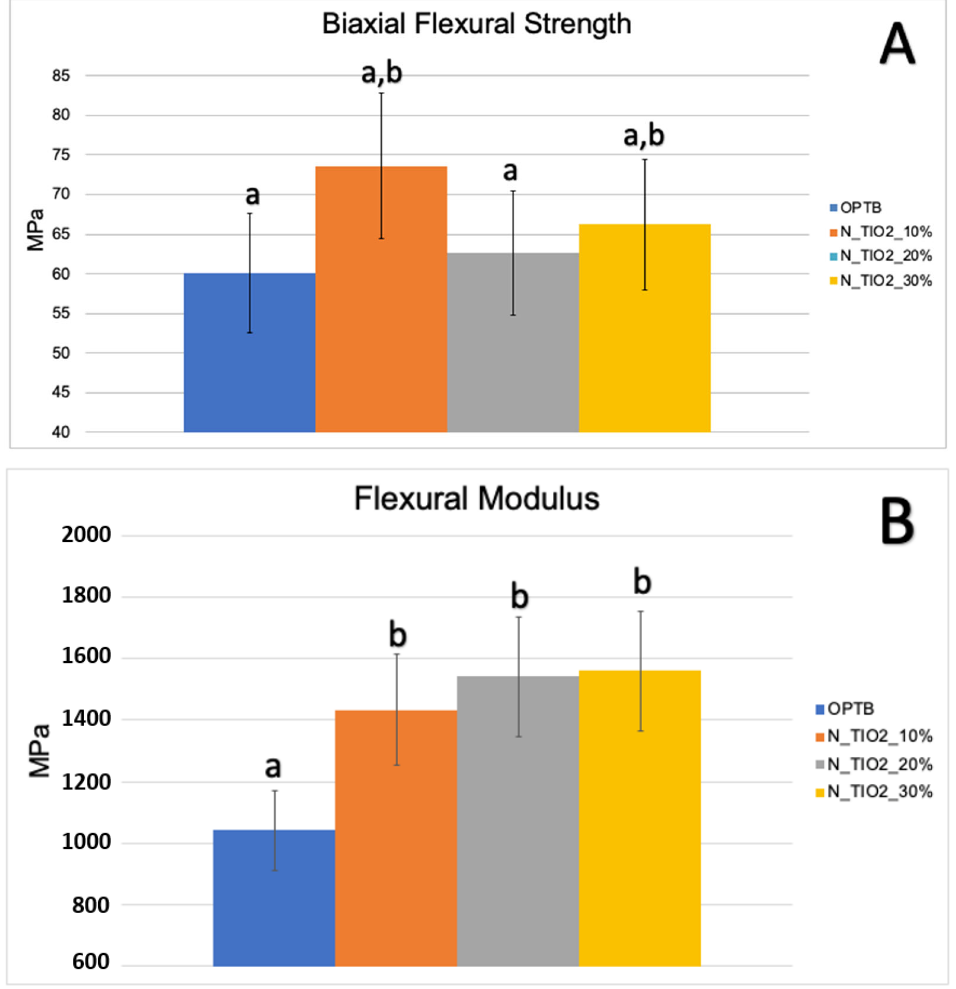
Figure 3. Mean and standard deviation values of ( A ) biaxial flexure strength (BFS) and ( B ) flexural modulus of unaltered (OPTB) and experimental adhesives (OPTB + N_TiO 2 [10%, 20%, or 30%, v / v ]). Letters above bars illustrate the SNK rankings and denote the presence of significant ( p < 0.05) intergroup differences.